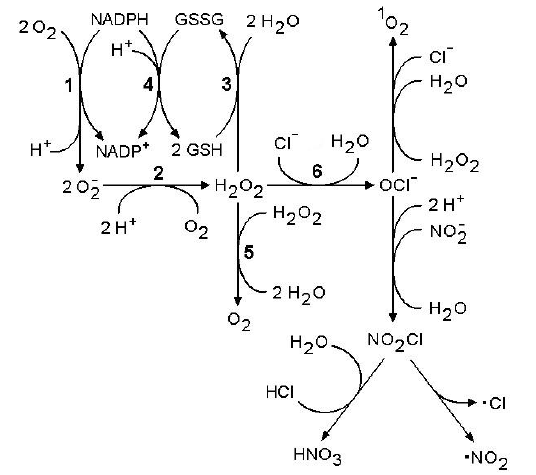
Figure 4. Simplified pathways leading to oxygen radical production by activated neutrophils. Plasma membrane NADPH oxidase (1) catalyses the reduction of molecular oxygen to superoxide anion, which undergoes a dismutation reaction (2) to form hydrogen peroxide. Hydrogen peroxide can be either scavenged through the reactions catalyzed by glutathione peroxidase (3), glutathione reductase (4), and catalase (5), or utilized by the myeloperoxidase (6) to form hypochlorite. Hydrogen peroxide can react with hypochlorite to form singlet oxygen. An additional reaction of hypochlorite is with nitrite to form nitryl chloride, which then hydrolyses to nitrate or decomposes to give strong oxidants such as nitrogen dioxide and . Cl radicals.